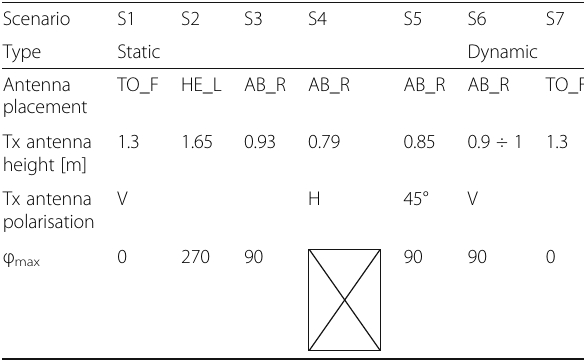
Table 1 Characteristics of the investigated scenarios